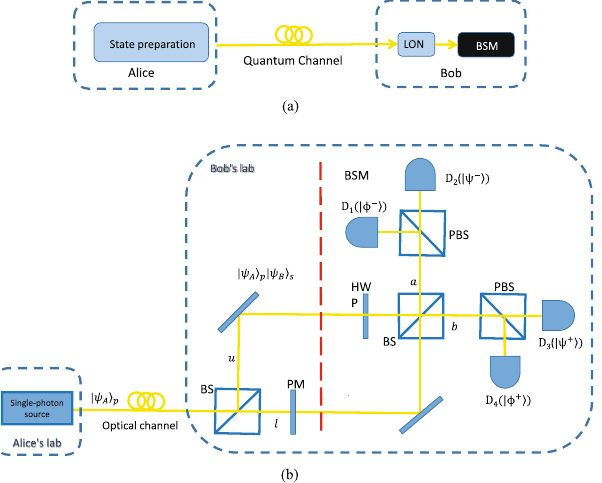
Figure 1. ( a ) Schematic diagram of DDI-QKD. LON is the linear optical network, and BSM is the Bell state measurement. ( b ) Schematic diagram of a specified example of DDI-QKD proposed in ref. 33. BS: 50:50 beam splitter, BSM: Bell state measurement, HWP: half-wave plate, PM: phase modulator, PBS: polarizing beam splitter, and D i , with ∈ i {1, 2, 3, 4} : single-photon detectors in the BSM setup. In Bob’s laboratory, the areas before and after the red dashed line denote the LON and the BSM setup, respectively. For the ideal case, a click on each detector D i corresponds to the projection on one of the four Bell states. | ψ A 〉 p is one of the four BB84 polarization states prepared by Alice, and | ψ B 〉 s are Bob’s encoding bit in spatial mode. Symbols u , l and a , b denote two paths of the first and second BS, respectively. In practice, Alice prepares | ψ A 〉 p by generating phase- randomized weak coherent pulses which can be modelled as Poissonian (with parameter u ) mixture of photon number states in different BB84 polarization states 1, 2, 29